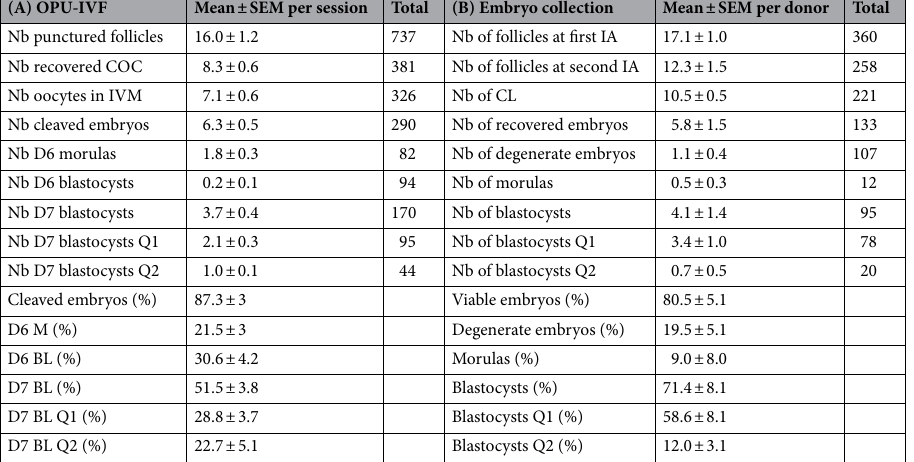
Table 1. A Embryo production data per session of OPU-IVF, ( B ) Embryo production data per session of embryo collection. Nb: number; Nb of CL: number of corpus luteum at embryo collection procedure; M: morula; BL: blastocyst ; D6 and D7: day 6 and 7 of development. Q1 and Q2: embryo quality based on International Embryo Technology Society